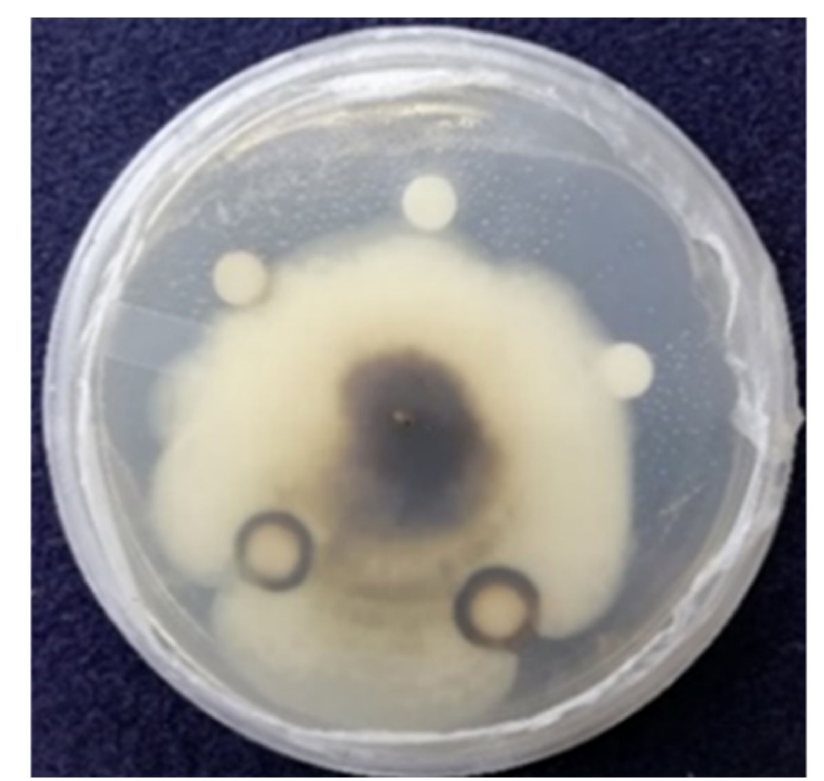
Figure 7. Antifungal activity of AgNPs against Magnaporthe grisea by disc diffusion